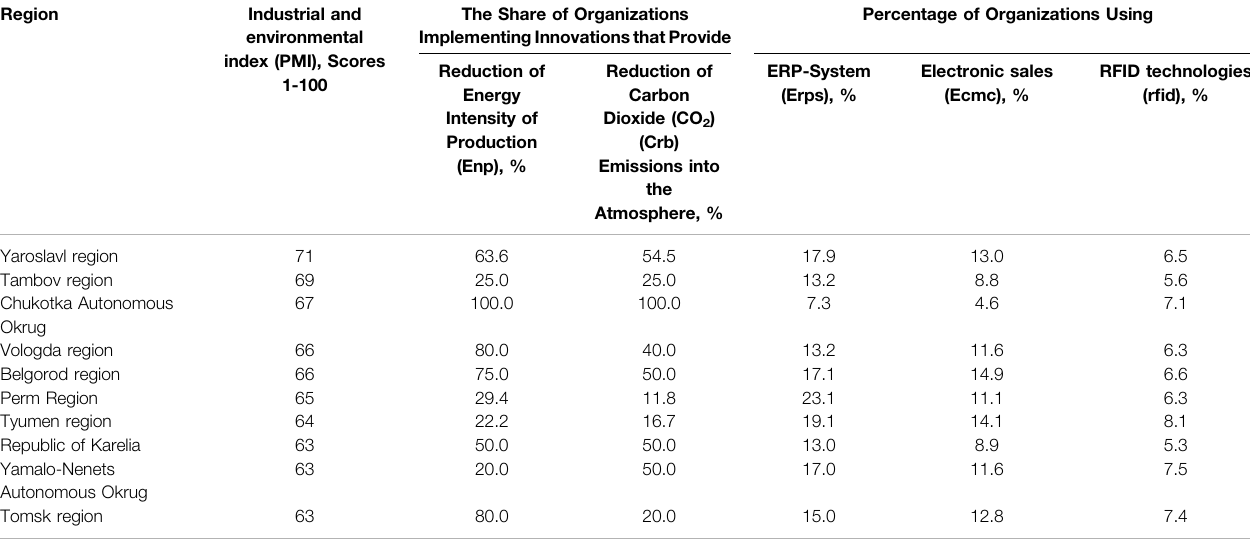
Percentage of Organizations Using